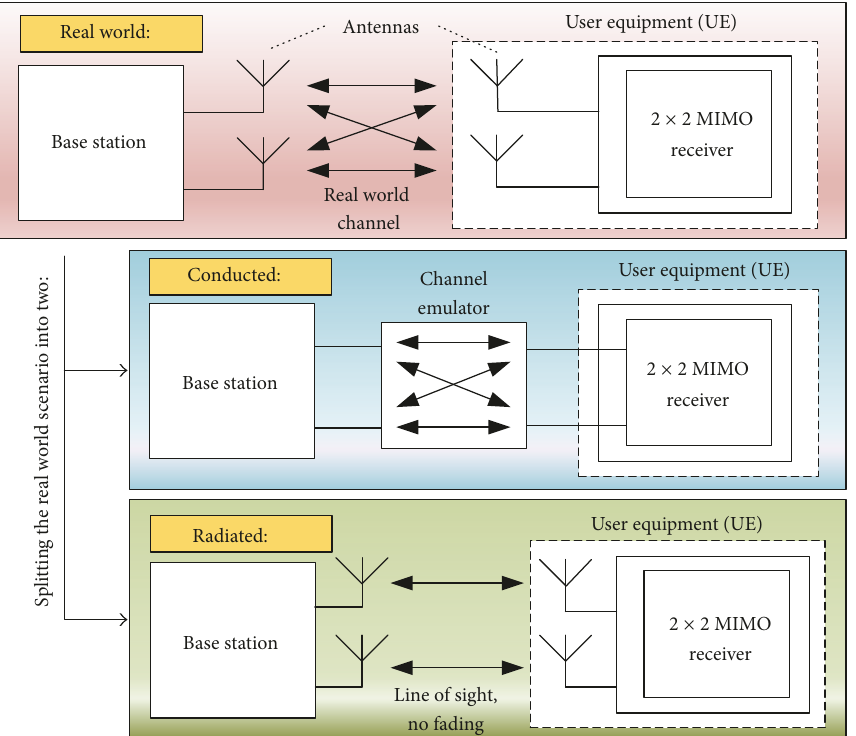
Figure 1: Splitting up the ideal “real world” scenario into two parts: a conducted and a radiated test setup for the downlink case of a 2 × 2 MIMO system [24].